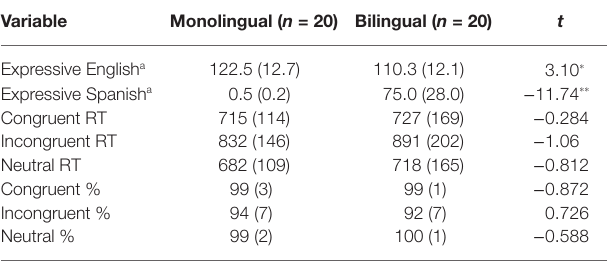
TABLE 3 | Vocabulary and inhibitory control measures by group.